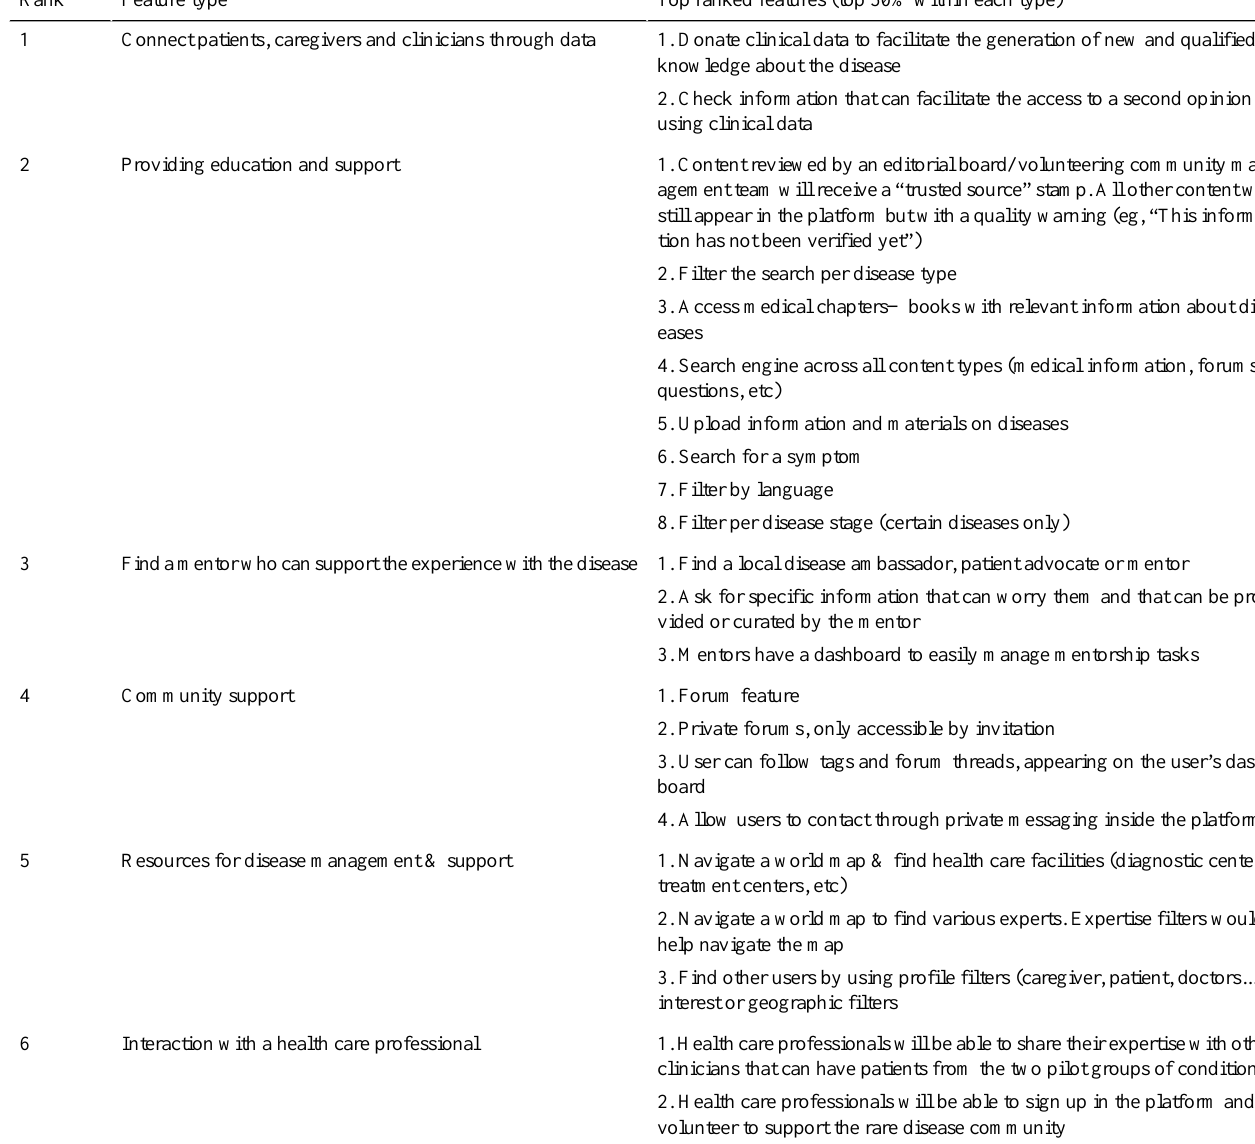
Top ranked features (top 50% within each type)Feature